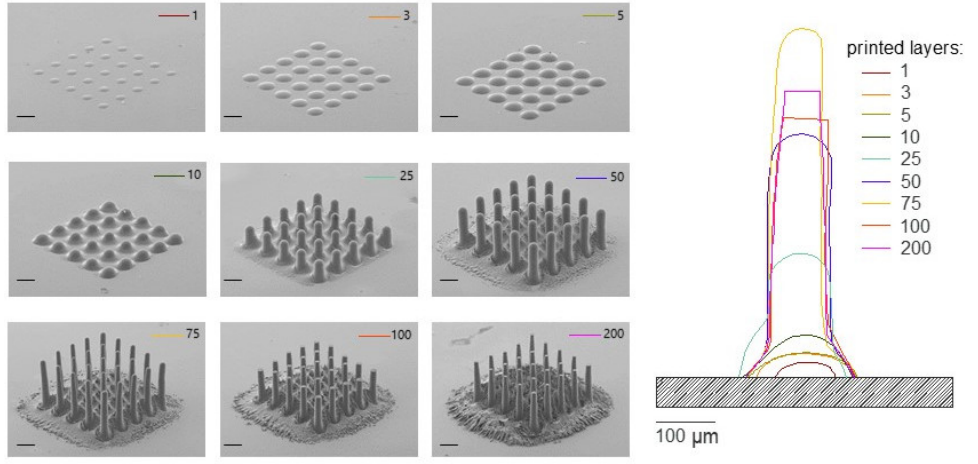
Figure 8. High aspect ratio pillar arrays with different numbers of printed layers ranging from 1 to 200, post-processed utilizing RIE. Height profiles of individual 3D pillars are presented on the right. Scale bar at images is 100 µ